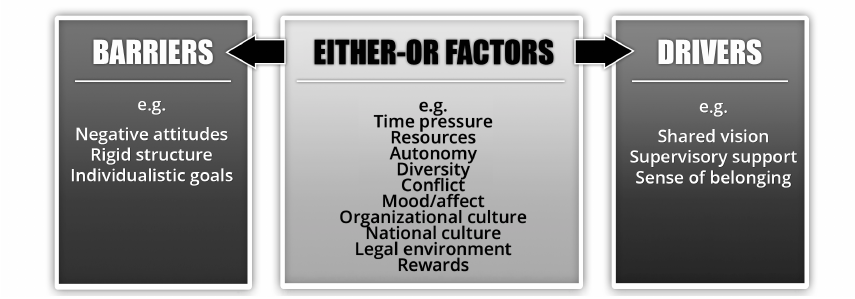
Fig. 1. Examples of barriers to, drivers and, either-or factors of organizational creativity The fact that under different circumstances the same factors might be either drivers or barriers was already explicitly reflected more than a decade ago by Amabile et al. (2002) in their discussion of the effect of time pressure on creativity under different conditions. According to Amabile et al. (2002), time pressure can act as a driver of creativity in case the employees can focus on the task and consider the task meaningful, whereas it can act as a barrier in case the task is fragmented, employees are often distracted, and the task does not feel meaningful. Some other scholars have, accordingly, discussed the contradicting or paradoxical influences of certain antecedents of organizational creativity, such as diversity and coherence (Bassett- Jones, 2005; Andriopoulos and Lewis, 2010), time and workload pressure (Baer